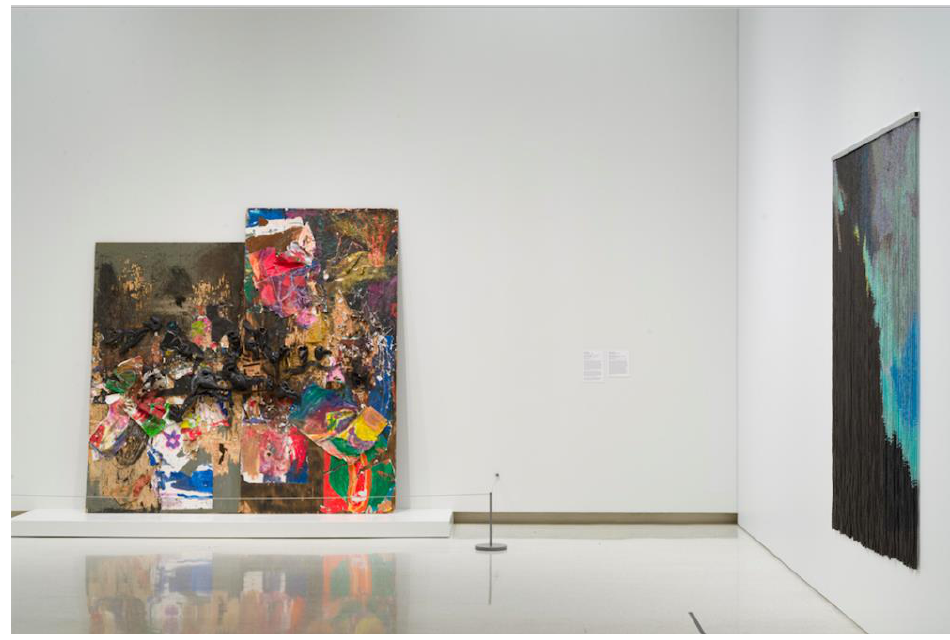
Installation view of 20/20: The Studio Museum in Harlem and Carnegie Museum of Art. Photo: Bryan Conley." Featuring Abigail DeVille Harlem World (2011) and Kori Newkirk Solon 6:12 (2000). Crosby and Hunt’s selection of works also highlighted the ability of minimalism, conceptualism, and abstraction to respond to political, cerebral, and spiritual themes. Quentin Morris’s enormous monochromatic circular painting, Untitled [January – February 1994] (1994), was given space to be sublime. Somehow it both absorbed light and shimmered, like a black sun reflecting on water. Edgar Arceneaux’s slid eshow, Blocking Out the Sun (2004), in which he repeats the youthful gesture of trying to blot out the sun by pinching one’s fingers, humorously nods to catastrophic climate change and to the ordinary metaphysics of seeing. Who doesn’t wish for the power t o sway the universe, even minorly, in times like these? 20/20 was not a show about, or of, black art. One might describe it as an exhibition of blackness in the U nited States. Artists’ races were not uniformly identified in the wall labels and several white artists were included. The title 20/20 referred to the number of artists chosen